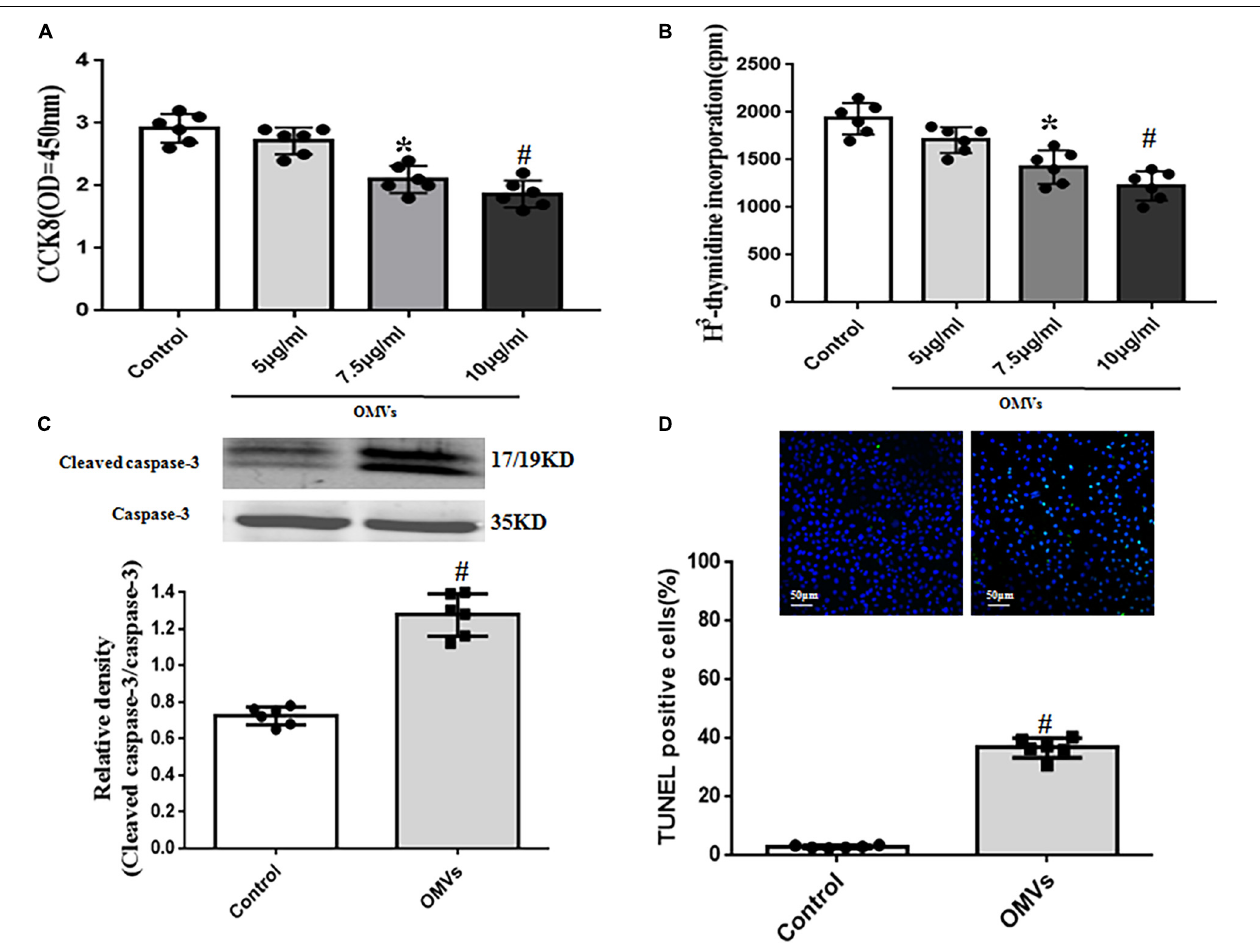
FIGURE 3 | Role of H. pylori -derived OMVs on proliferation and apoptosis of HUVECs. (A,B) Proliferation of HUVECs treated with H. pylori -derived OMVs (5, 7.5, 10 µ g/ml) were assayed by cell counting kit-8 (CCK8) (A) and [ 3 H] thymidine incorporation (B) . Absorbance was detected at 450 nm ( n = 6, * P < 0.05 or # P < 0.01 vs. control. (C) Cleaved caspase-3 and total caspase-3 levels in HUVECs were determined by immunoblotting. Data were expressed as the ratio of cleaved caspase-3 to total caspase-3 expression ( n = 6, # P < 0.01 vs. control). (D) Apoptosis of HUVECs was determined by TUNEL staining. Data were expressed as the ratio of apoptotic cells to total cells ( n = 6, # P < 0.01 vs.